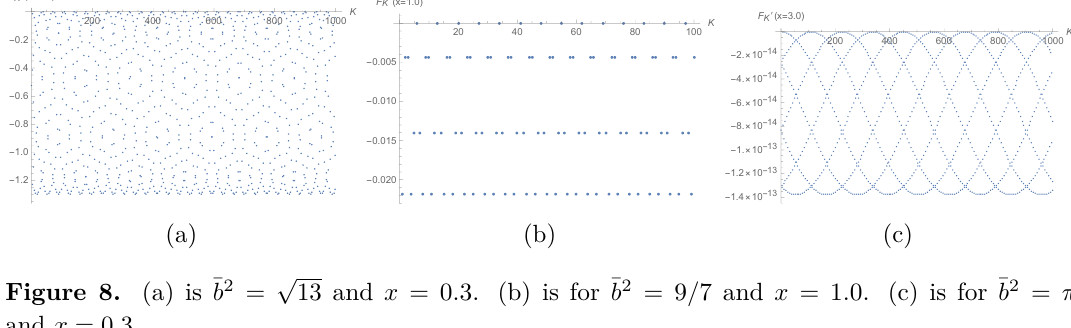
√ Figure 8. (a) is ¯ b 2 = 13 and x = 0 . 3 . (b) is for ¯ b 2 = 9 / 7 and x = 1 . 0 . (c) is for ¯ b 2 = π and x = 0 . 3